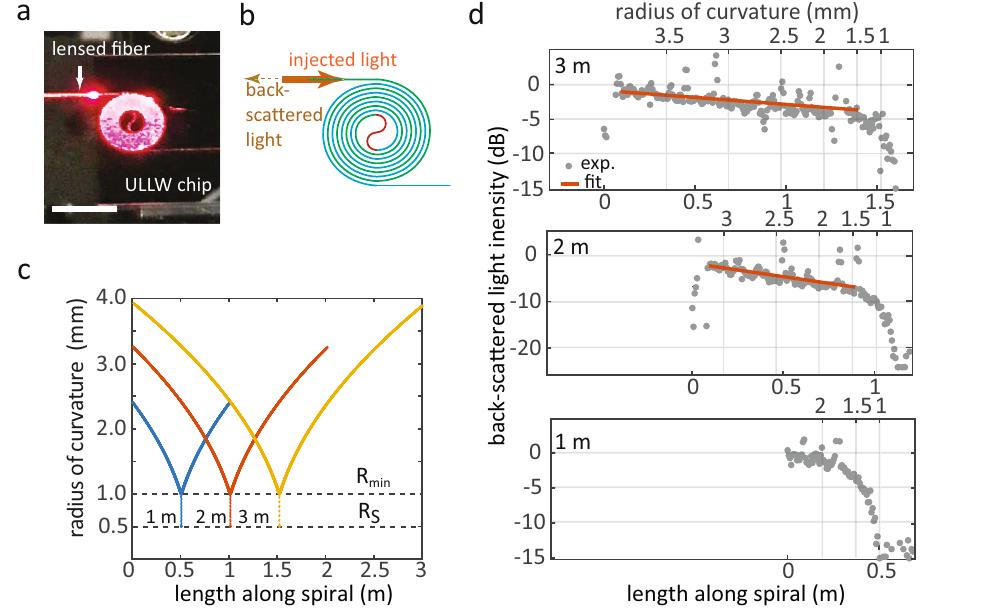
measured 1m, 2m, and 3m spirals. R min and R S respectively mark the minimum spiral and S-bend radii. We note the large RoC discontinuity at the S-bend. d Back- scatteredlightintensityasafunctionofpropagationlengthandRoCalongthe1m, 2m, and 3m spirals, relative to the intensity at the start of each spiral (dots: data; red lines: fi ts). In each panel, the top and bottom horizontal axes are, respectively, theRoCand lengthalongthe corresponding spiral.Thespirallengthuncertaintyis <1 mm, as described in the Supplementary Note